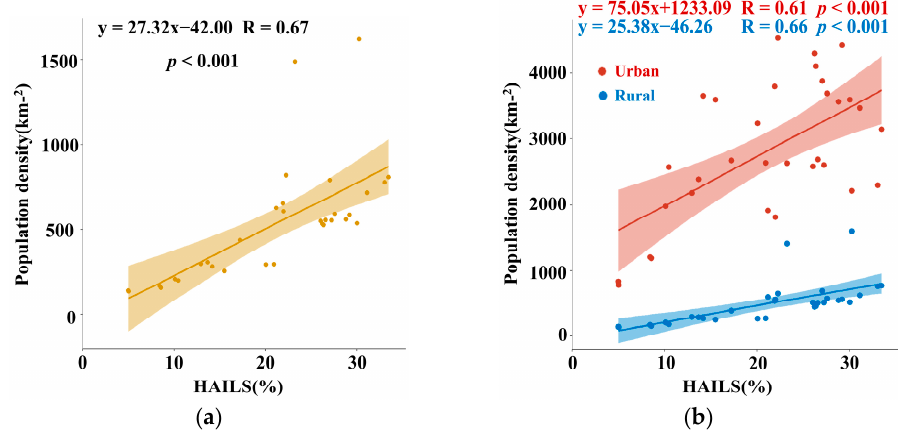
Figure 5. Correlation between population density and the HAILS: ( a ) population density; ( b ) rural and urban population densities.